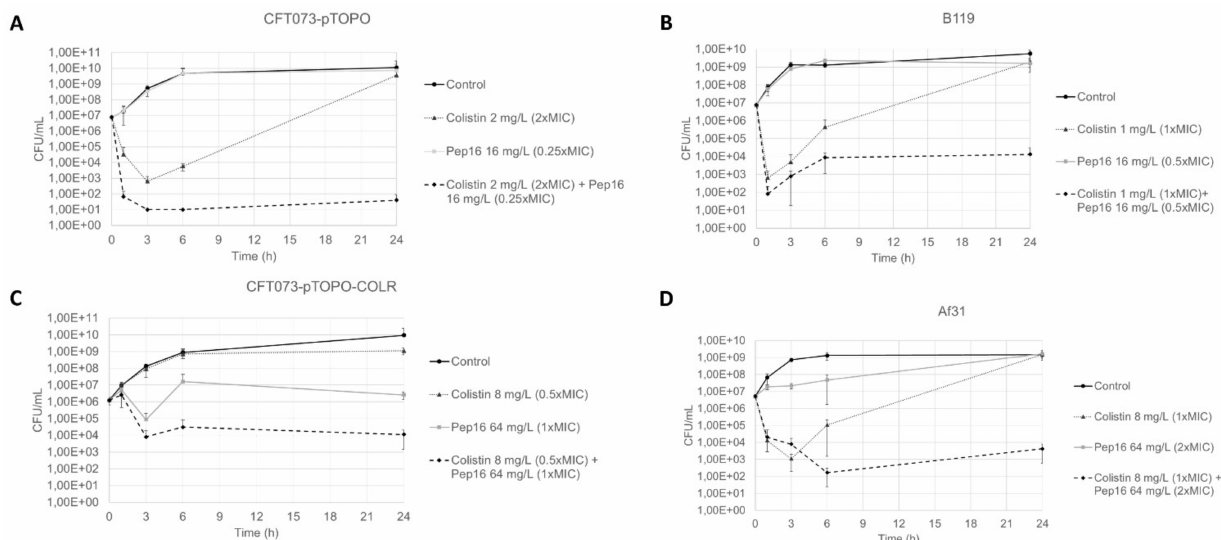
Figure 1. Time–kill curves of Pep16 and colistin alone or in combination against the studied strains at inocula between 10 6 and 10 7 CFU/mL. ( A ) CFT073-pTOPO. ( B ) B119. ( C ) Af31. ( D ) CFT073-pTOPO- COLR. Data expressed as the mean and the standard deviation. All experiments were conducted at least 3 times.